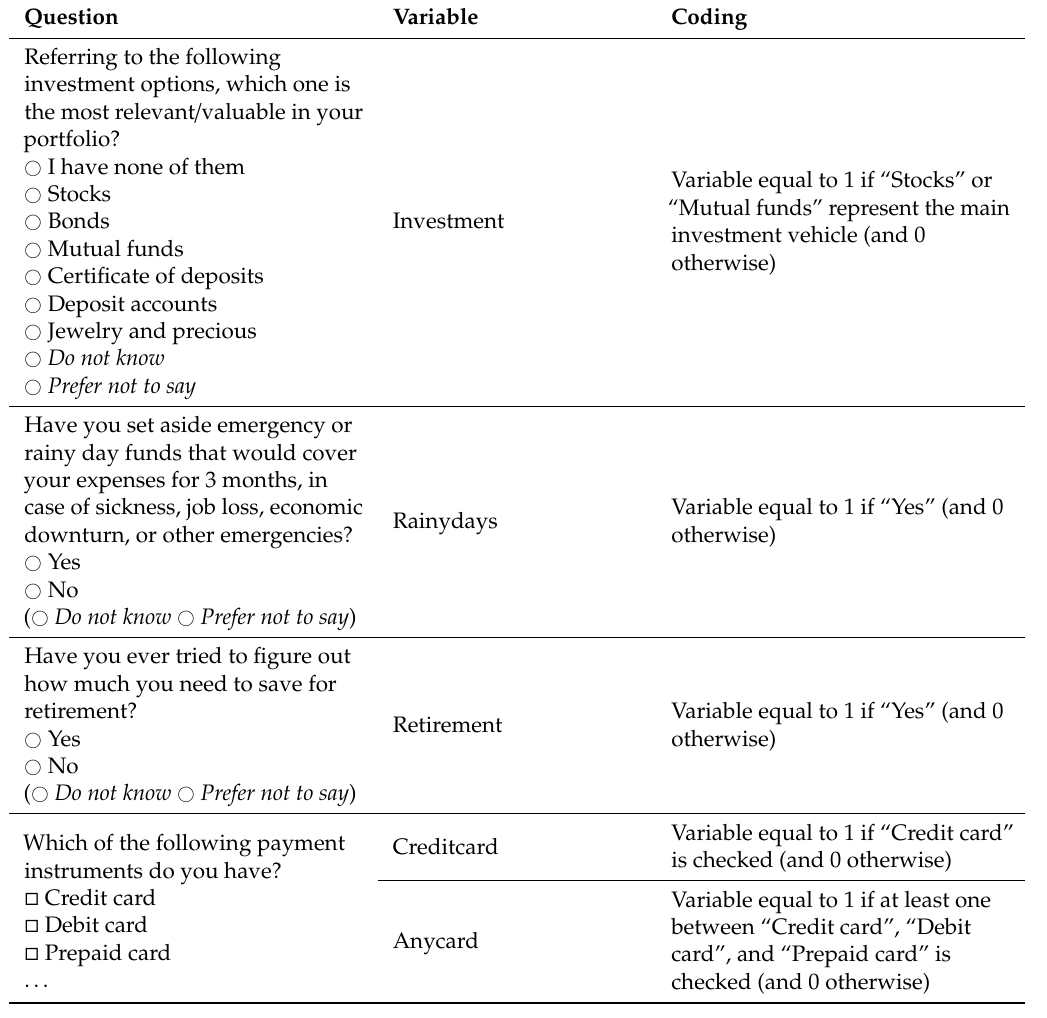
Table 1. The dependent variables: financial